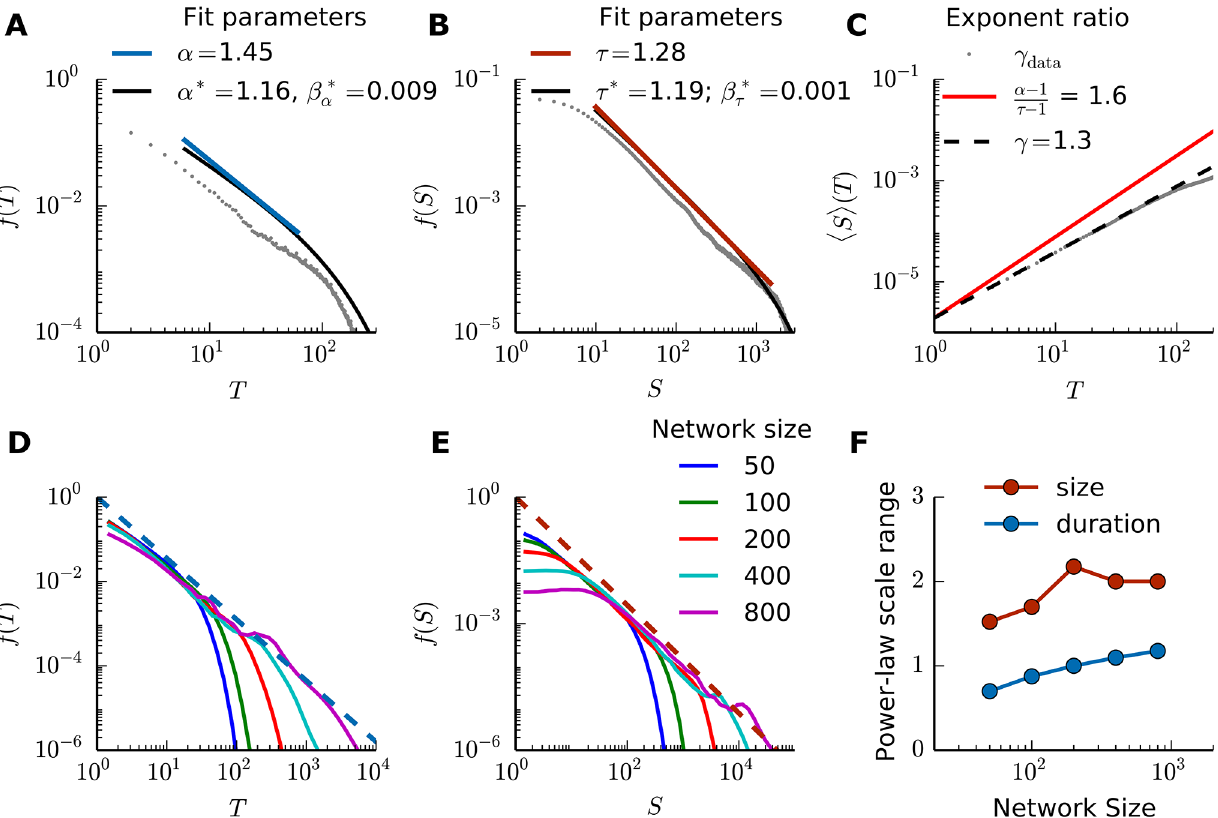
Fig 2. Power-law distributed neuronal avalanches in the SORN’s stable phase. (A), (B) Normalizeddistributions of duration T and size S of neuronalavalanches, respectively, for N E = 200. The raw data points of 50 independentSORN simulations are shown in gray. The power-law fit is shown in blue/redand the power-lawwith exponential cut-off fit is shown in black for comparison. (C) Avalanches’ averagesize h S i ( T ) as a function of duration, for simulateddata (gray) and theoretical prediction(red). The dashed black line shows a power-law with exponent γ = 1.3, approximately fitting the raw data from SORN simulations. (D), (E) Scaling of avalanches’ distributions for networksof different sizes. Dashed lines show the exponents α and τ calculatedfrom pure power-laws for N E = 200 (shown in the top row). (F) Power-lawrange for networks of different sizes, obtained by estimatingthe cut-off point. All distributions show combineddata of 50 independent simulations.